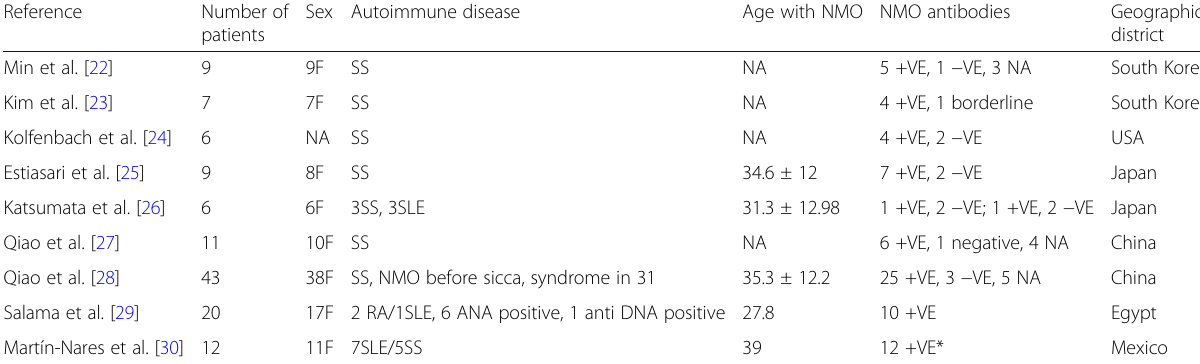
Table 1 Comparison of studies of NMO clinical syndromes and systemic autoimmune rheumatic diseases